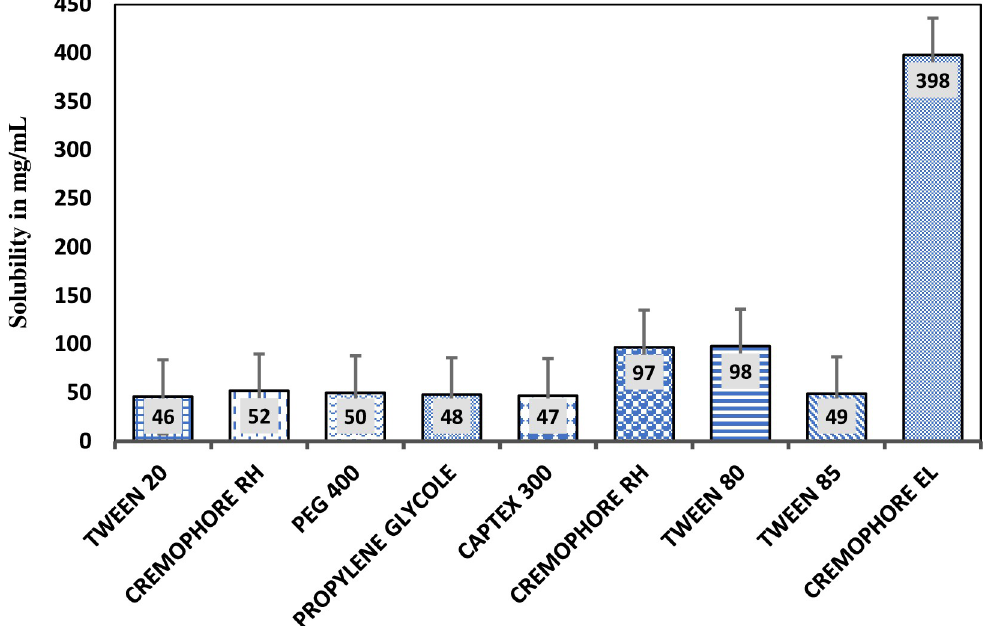
Fig 2. Solubility studies of iodine in different